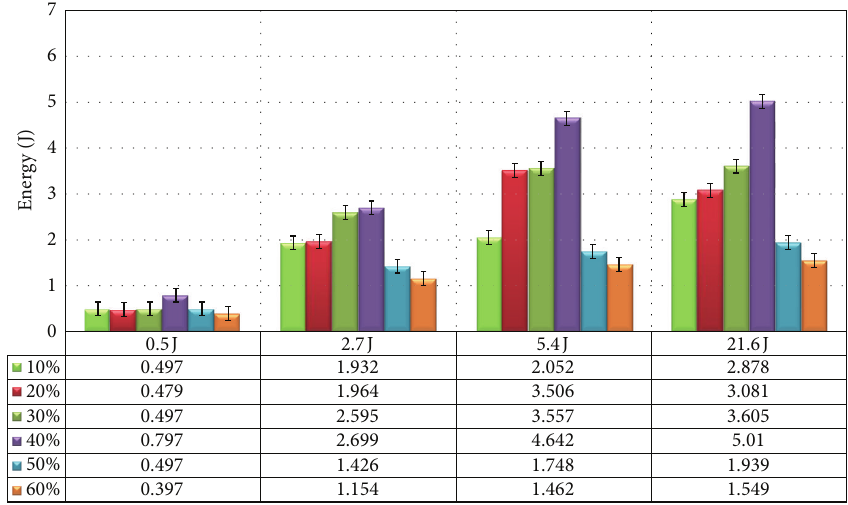
Figure 6: Effect of fiber content on impact energy of kenaf/PVB composites at different energy